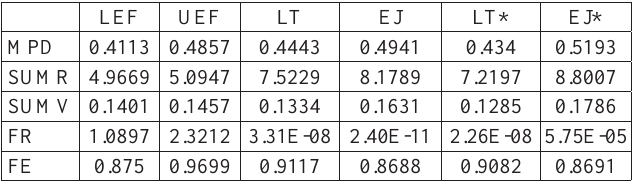
Table 2. Results of the Principal Coordinate and Functional Richness analyses, showing the disparity metrics for the taxon-bins of inter- est. Abbreviations: EJ, Early Jurassic; FE, functional evenness; FR, functional richness; LEF, lower Elliot Formation; LT, Late Triassic; MPD, mean pairwise distance (pre-ordination); SUMR, sum of ranges; SUMV, sum of variance; UEF, upper Elliot Formation. Asterisk de- notes removal of Thecodontosaurus and Pantrydraco from the LT, and the addition of Gongxianosaurus and Vulcanodon to the EJ.